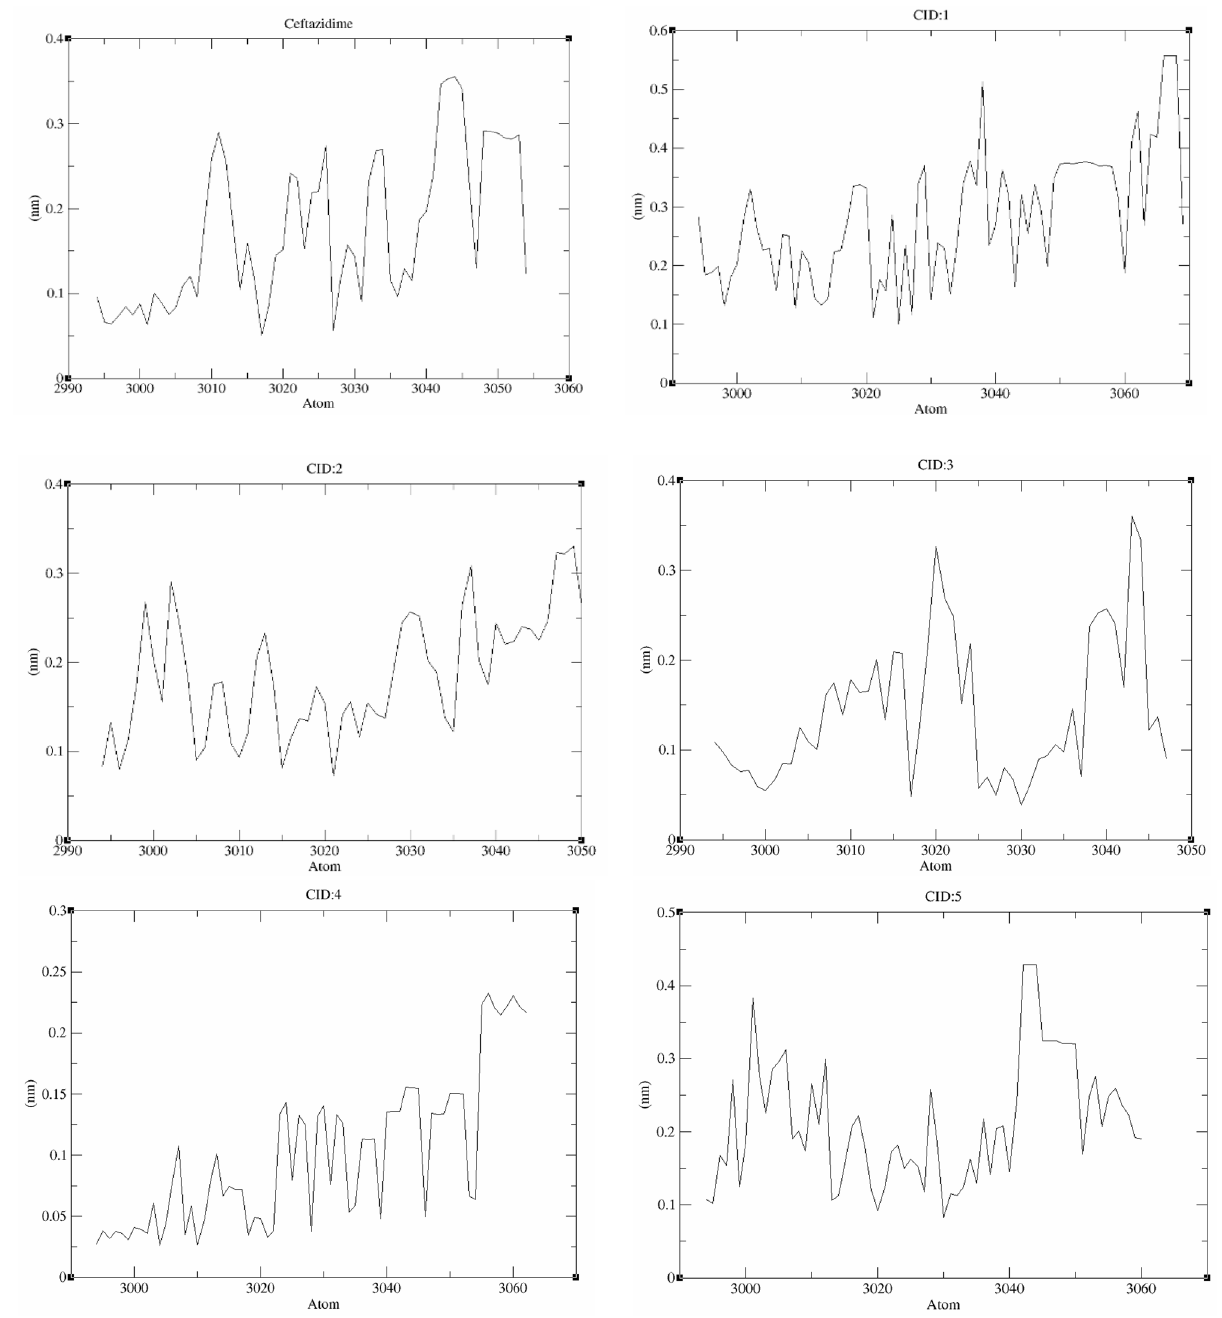
Figure 5. Root mean square fluctuations (RMSFs) of the ligand–protein complexes generated during MD